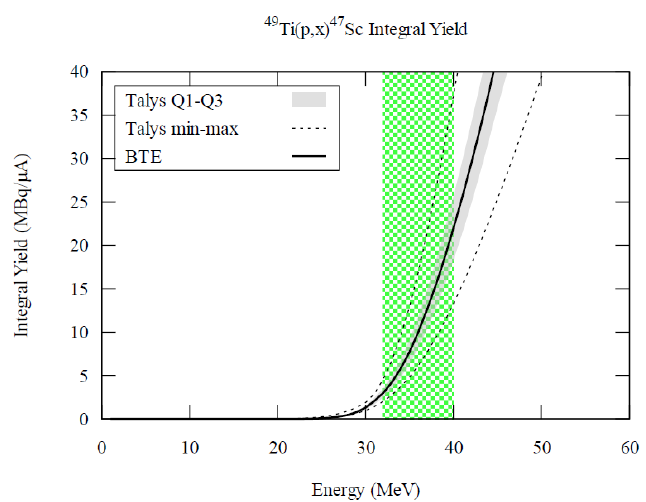
Fig. 5. Predicted yield for 47 Sc from 49 Ti. The yield has been calculated for a current I 0 = 1 μA and irradiation time T = 1h. The green area highlights the energy window (40-32 MeV) that optimizes the production of 47 Sc.